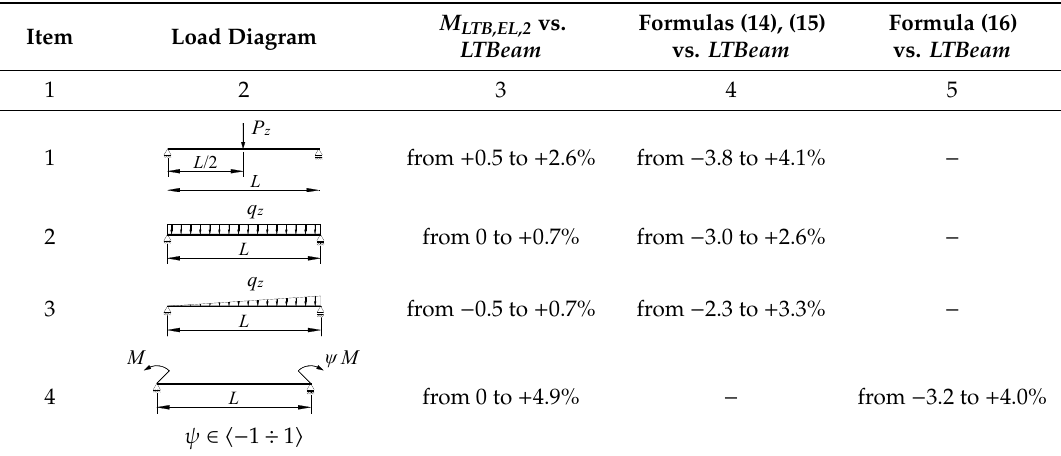
Figure 5. The critical moment of lateral torsional buckling of beam as a function of the index of fixity κ u , for selected index of fixity κ ω : ( a ) beam with concentrated force load, ( b ) beam with uniformly distributed load. Table 6. Percentage differences in the values of M cr for all analysed beams.